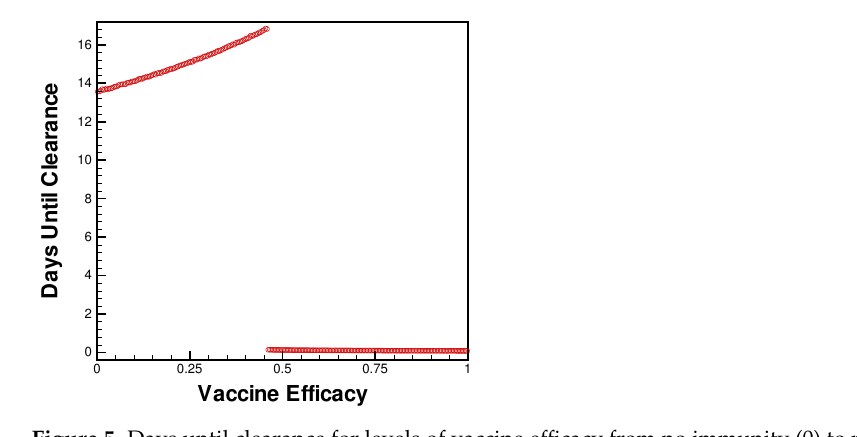
Figure 5. Days until clearance for levels of vaccine efficacy from no immunity (0) to natural antibody levels of immunity (1).